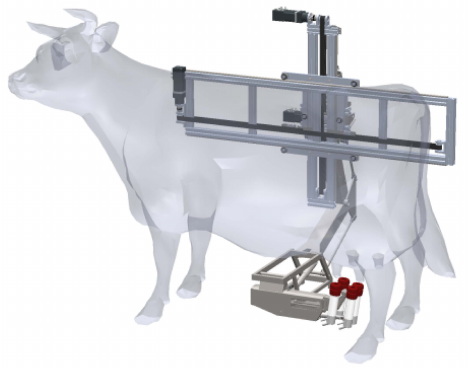
Figure 21. Kinematic model of a milking robot